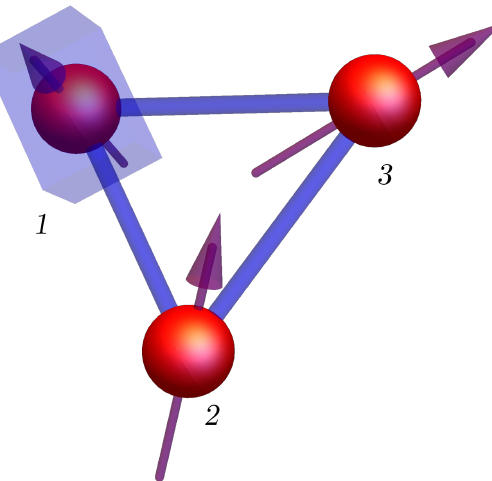
Figure 3: Anti-synchronizing two spin-1 / 2 (sites 2, 3) via a non-Markovian bath. The bath is the site 1 spin and the L = γσ −